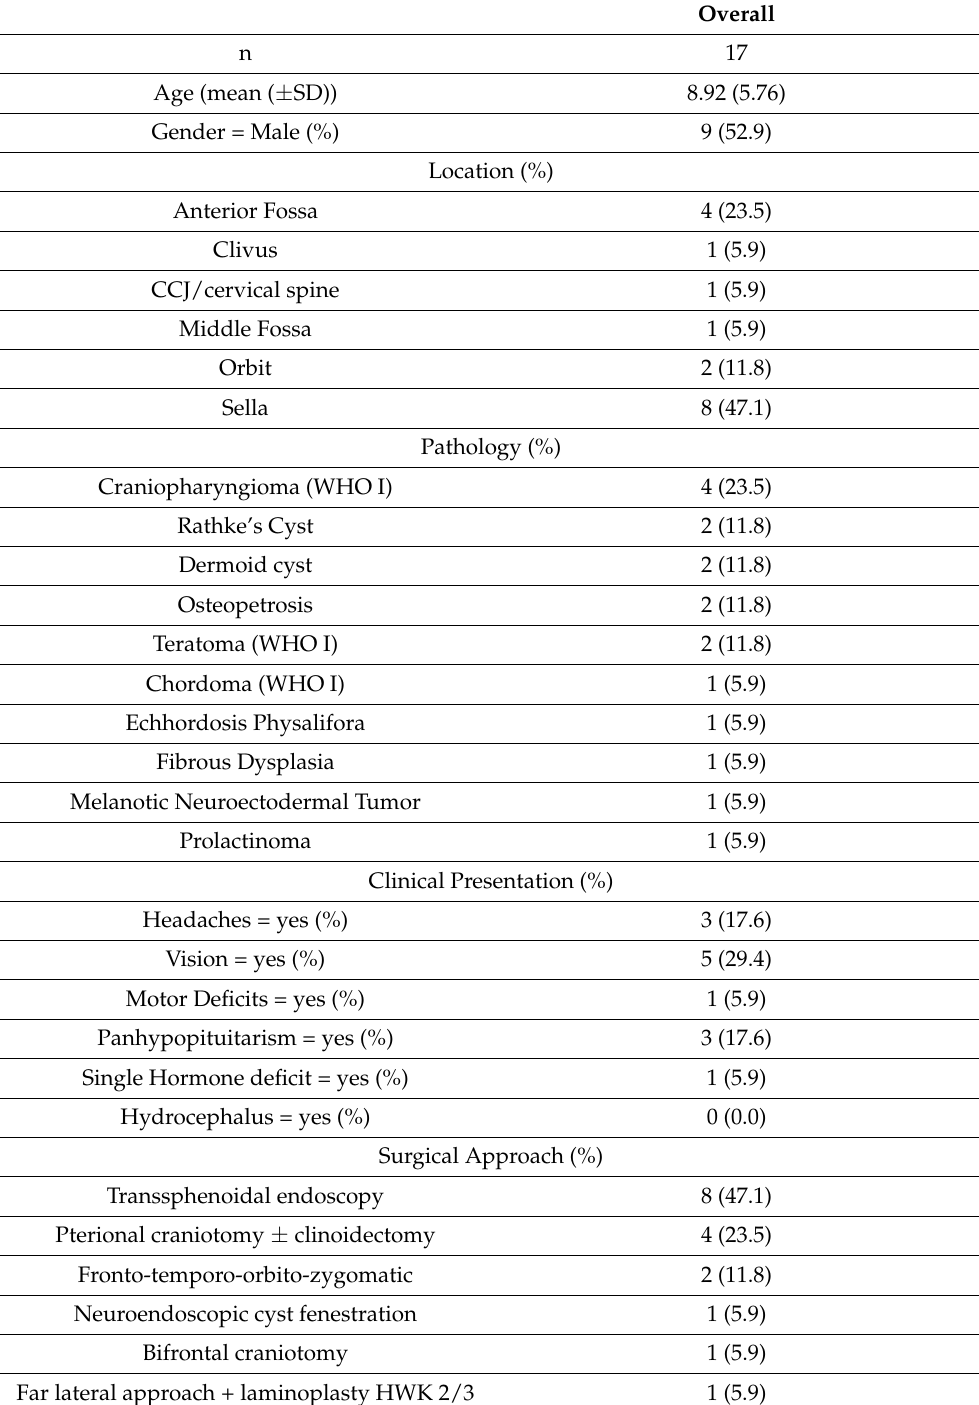
Table 1. Demographic